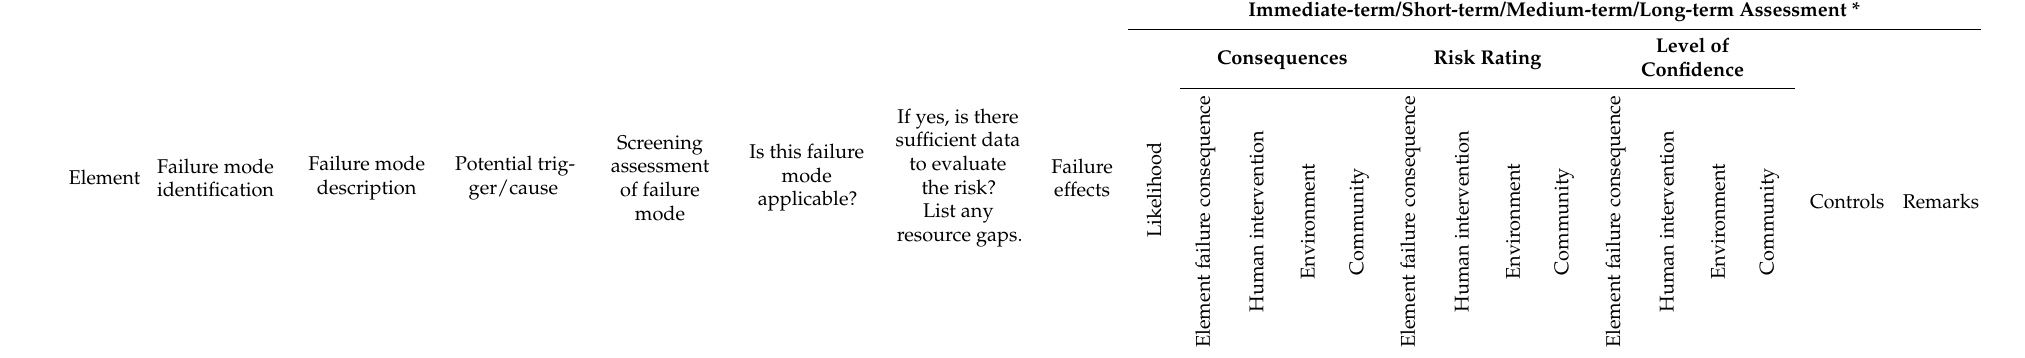
Table A5. G-FMEA